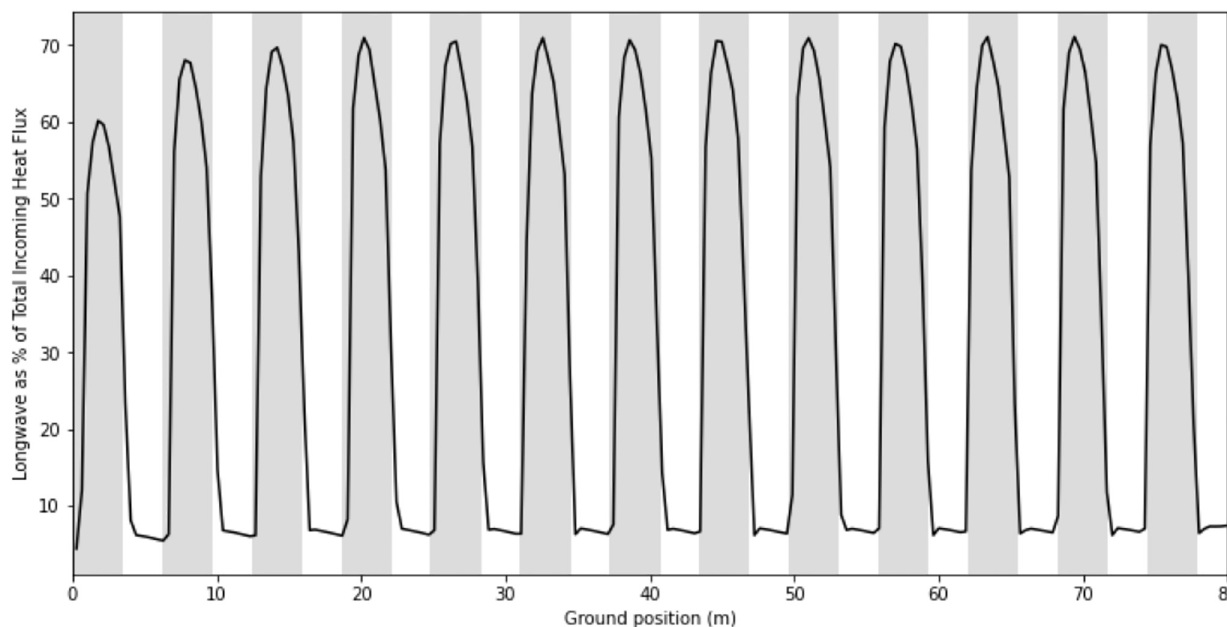
Fig 14. Longwave radiative heat flux as a percentage of the total incoming heat flux (Fig 13b) for all ground positions.